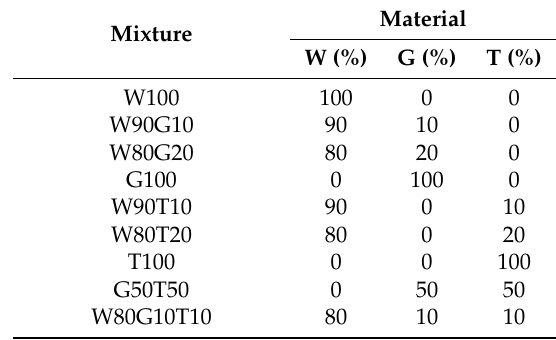
Table 1. The compositions of the individual mixtures used for analysis and monitoring.